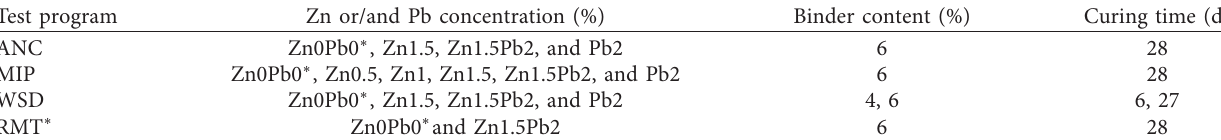
Table 3: Zn and Pb concentrations and curing times for various tests and analyses of spiked soils. Test program Zn or/and Pb concentration (%) Binder content